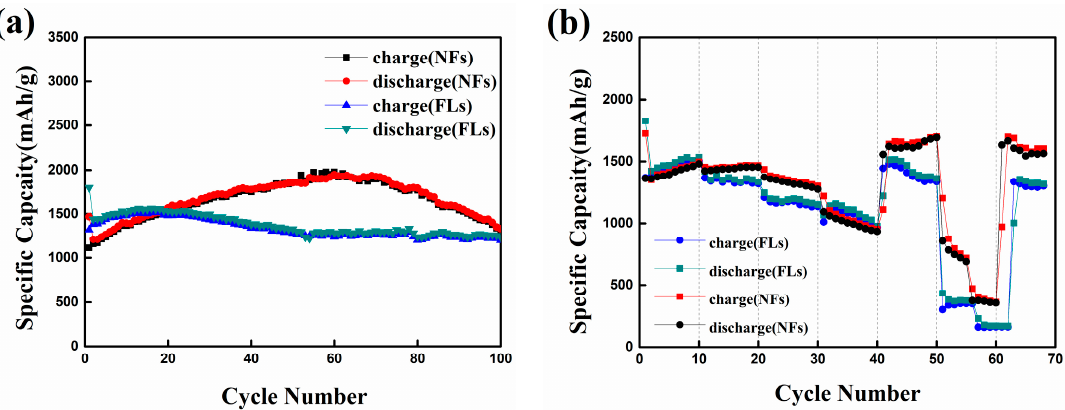
Figure 5. ( a ) Comparative cycling performance of CoO-NFs and CoO-FLs at 100 mA g − 1 ; ( b ) the rate capability of CoO-NFs and CoO-FLs at different current densities.